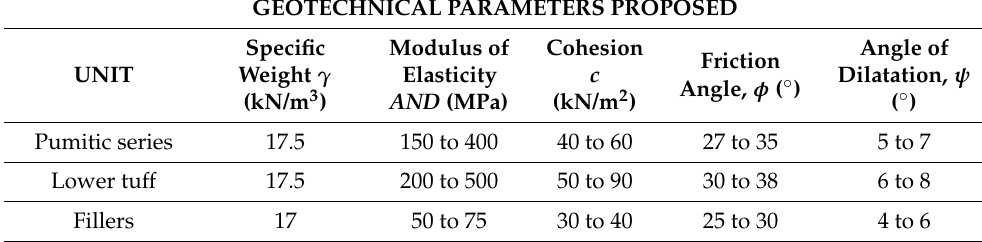
Table 2. Geotechnical parameters proposed.